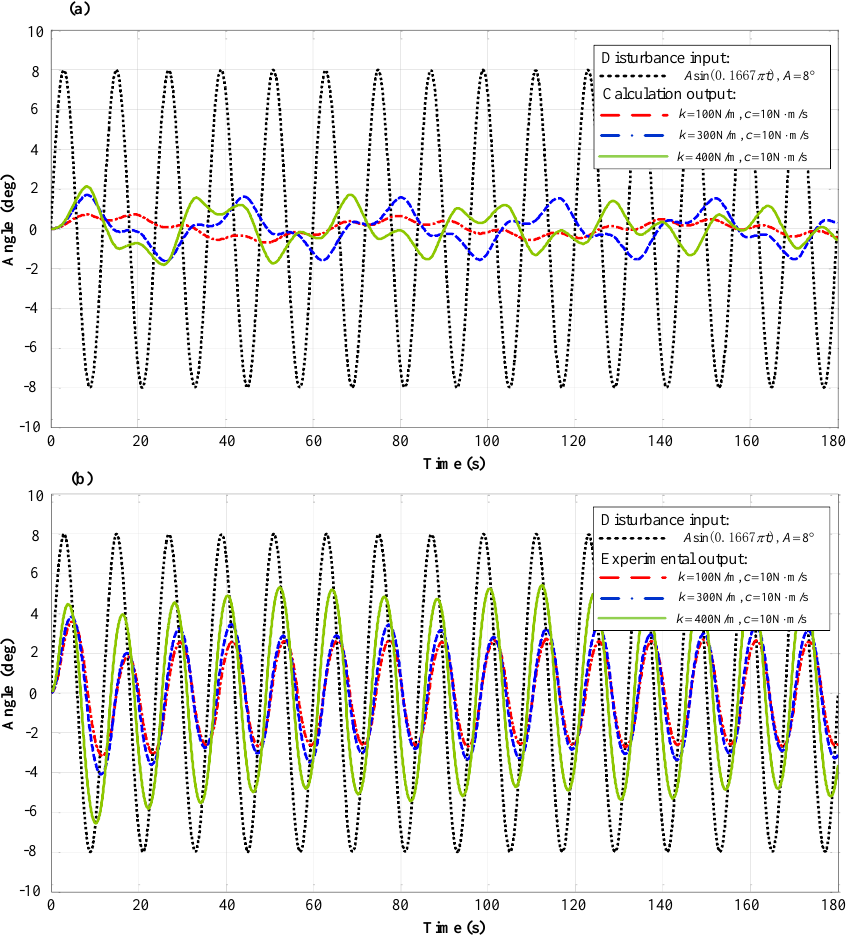
Figure 12. Influence of spring stiffness on isolation performance. ( a ) Simulation output; ( b ) experimental output.